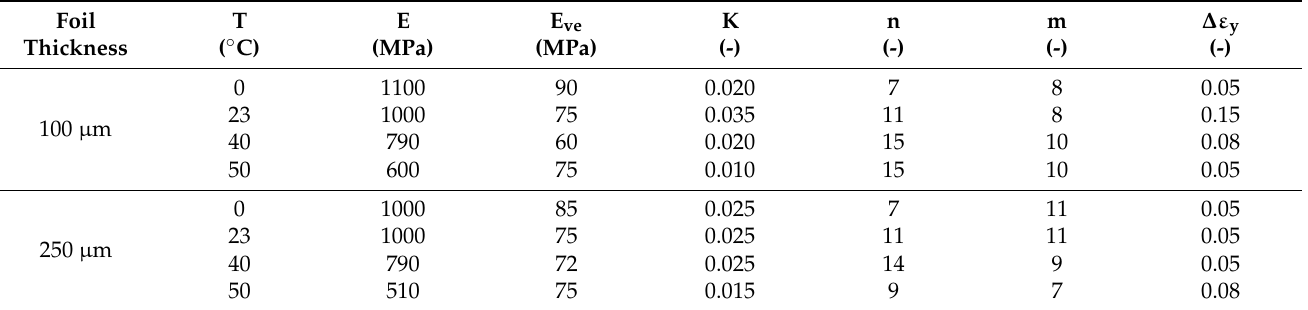
Table 5. Derived characteristic model parameters describing the temperature and strain rate depen- dence of f ve (MPa) and f y (MPa) of ETFE